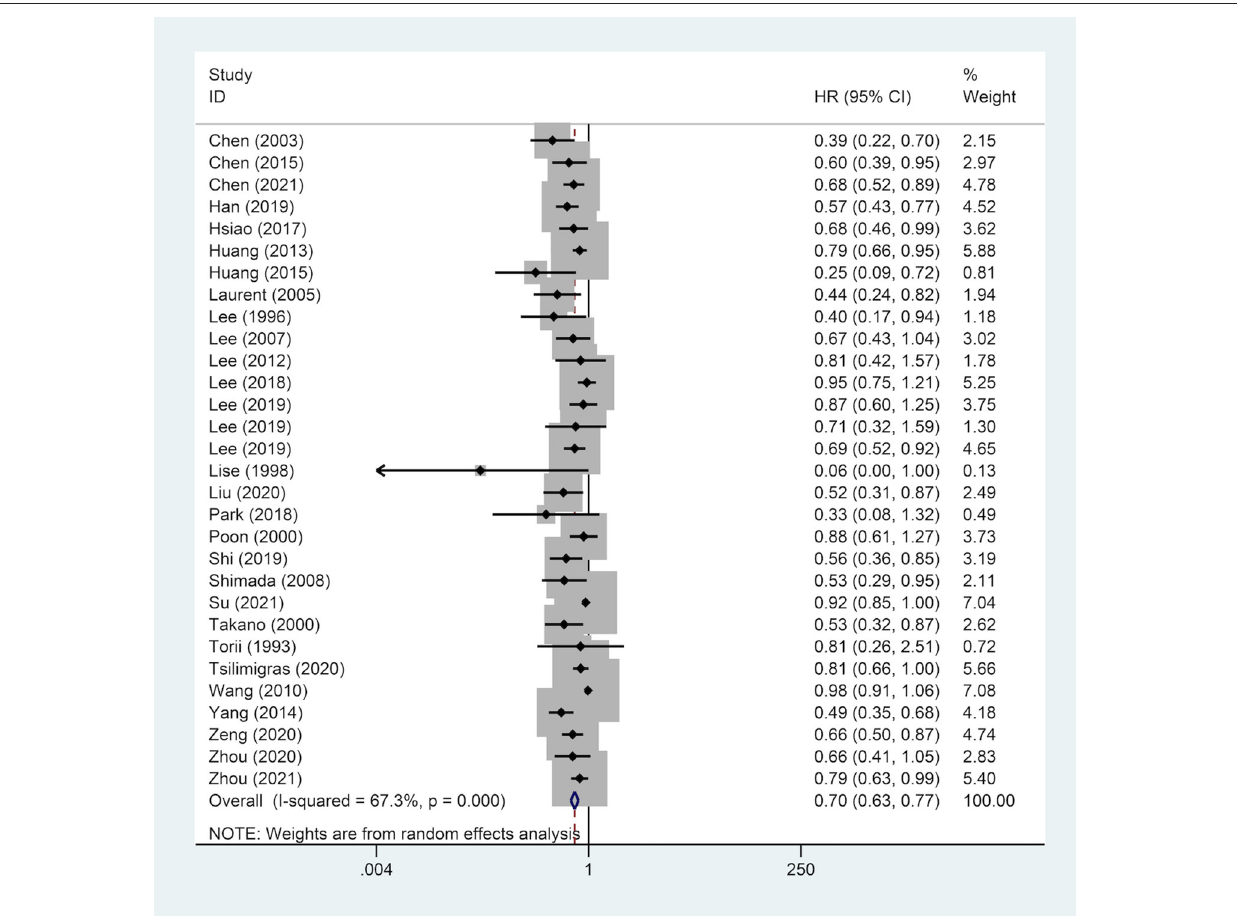
Frontiers in Surgery |